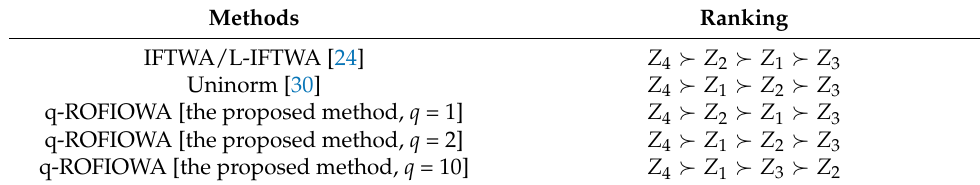
Table 2. Different methods of alternative